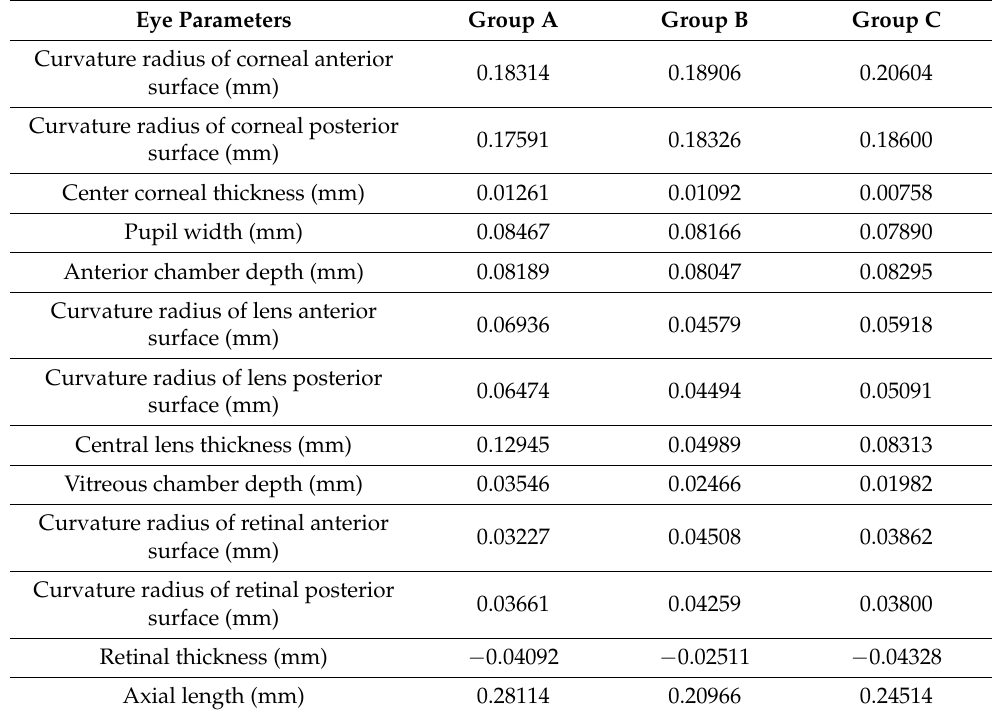
Table 1. The D-value of eye parameters before and after the